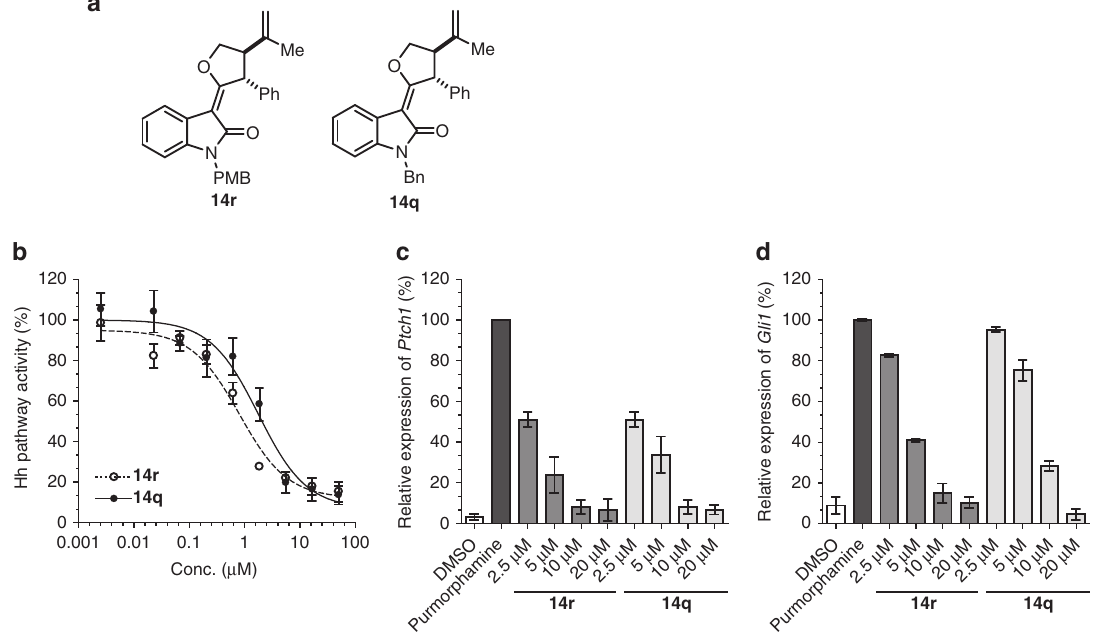
Figure 6 | 14q and 14r inhibit Hh signalling. ( a ) Structures of 14r and 14q . ( b ) 14r and 14q inhibit Gli-dependent reporter gene expression in Shh Light II cells. Cells were treated with 1.5 m M purmorphamine and different concentrations of compounds for 48h. Firefly and Renilla luciferase activities were then determined and ratios of firefly luciferase/Renilla luciferase signals were calculated, which are a measure of Hh pathway activity. Nonlinear regression analysis was performed using a four parameter fit. 14r and 14q suppress the expression of the Hh target genes Ptch1 ( c ) and Gli1 ( d ). C3H10T1/2 cells were treated with purmorphamine (1.5 m M) and different concentrations of 14r and 14q or DMSO as a control for 48h before isolation of total RNA. Following complementary DNA (cDNA) preparation, the relative expression levels of Ptch1 , Gli1 and Gapdh were determined by means of quantitative PCR employing specific oligonucleotides for Ptch1 and Gli1 or Gapdh as a reference gene. Expression levels of Ptch1 and Gli1 were normalized to the levels of Gapdh and are depicted as percentage of gene expression in cells activated with purmorphamine (100%). All data are mean values of three independent experiments ( n ¼ 3) ± s.d.